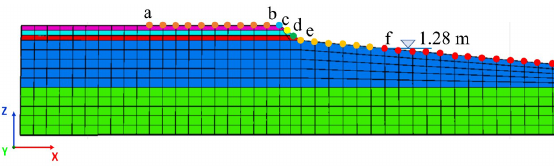
Figure 31. Initial sea level and control points considered for the earthquake–tsunami loading analysis.